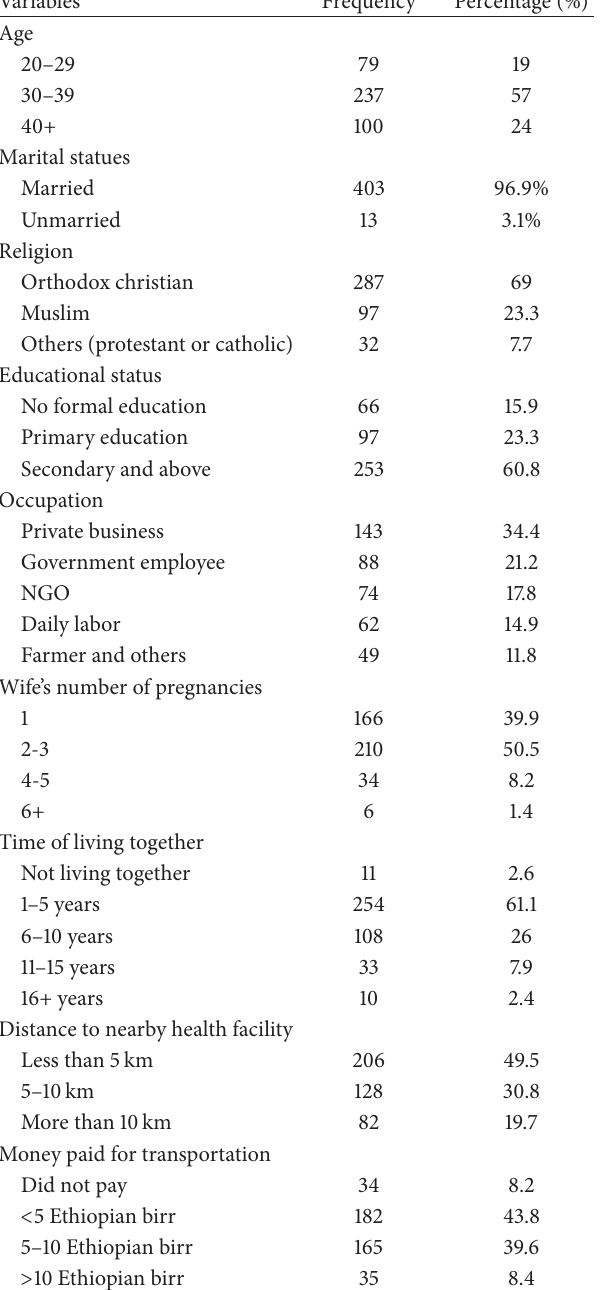
Table 2: Knowledge and attitude towards PMTCT and risk per- ception of male partners of pregnant women in Gondar town, Northwest Ethiopia,